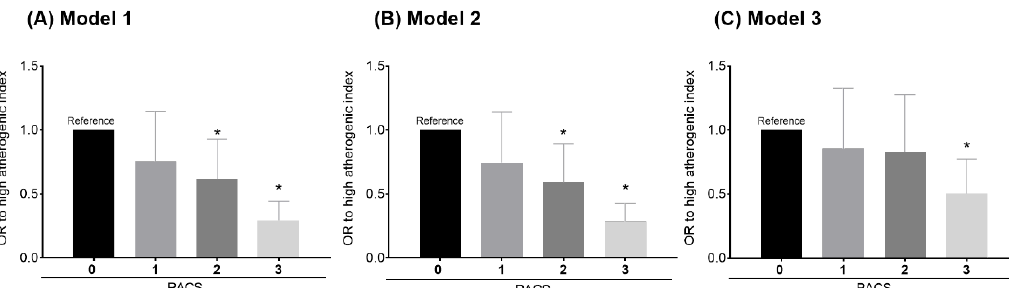
Figure 1. ( A ) Model 1 shows the binary logistic regression PACS score (number of met recommendations) for the Aherogenic Index AIP (elevated / non-elevated) adjusted for age and sex. ( B ) Model 2 is adjusted for model 1 plus tobacco, alcohol consumption, and educational level. ( C ) Model 3 is adjusted model 2 plus the Waist Circumference to Height Ratio WHtR. OR: odds ratio. Error bars represent the confidence interval (95% CI). * p -value < 0.05.